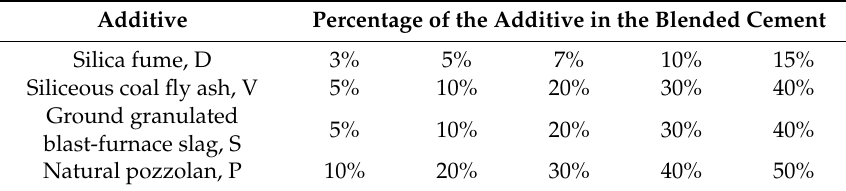
Table 1. Percentage of the additive in the blended